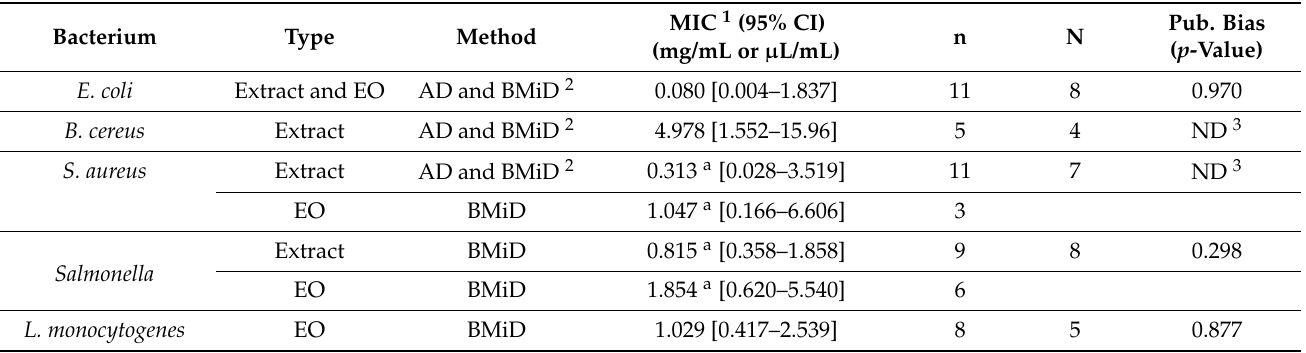
Table 6. Pooled MICs (mean and 95% confidence intervals, CIs) produced by extracts (in mg/mL) or EOs (in µ L/mL) of clove by method of determination (agar dilution (AD) and broth micro- dilution (BMiD)), as estimated by meta-analysis models separately adjusted by bacterium. Number of observations (n), number of primary studies (N), and p -value of the publication bias test are displayed per meta-analysis model.